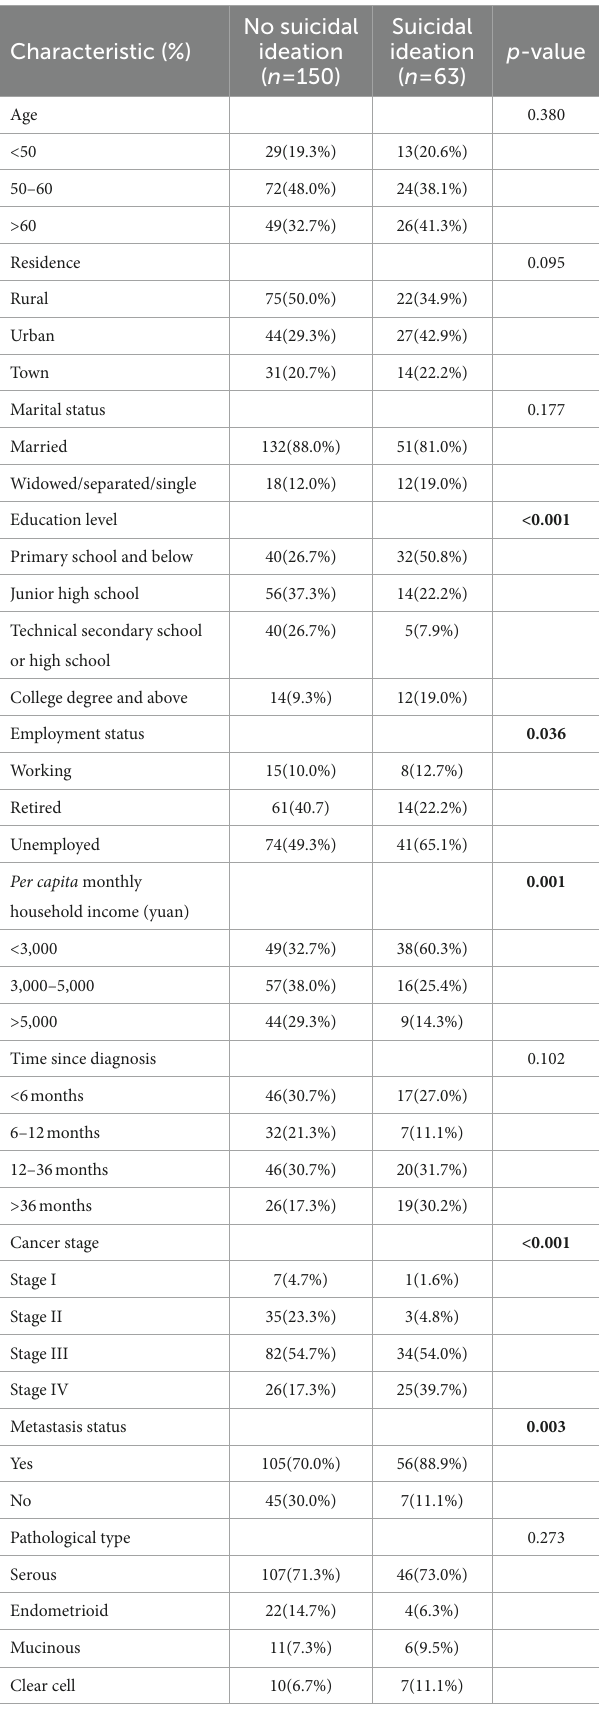
TABLE 1 General characteristics of ovarian cancer